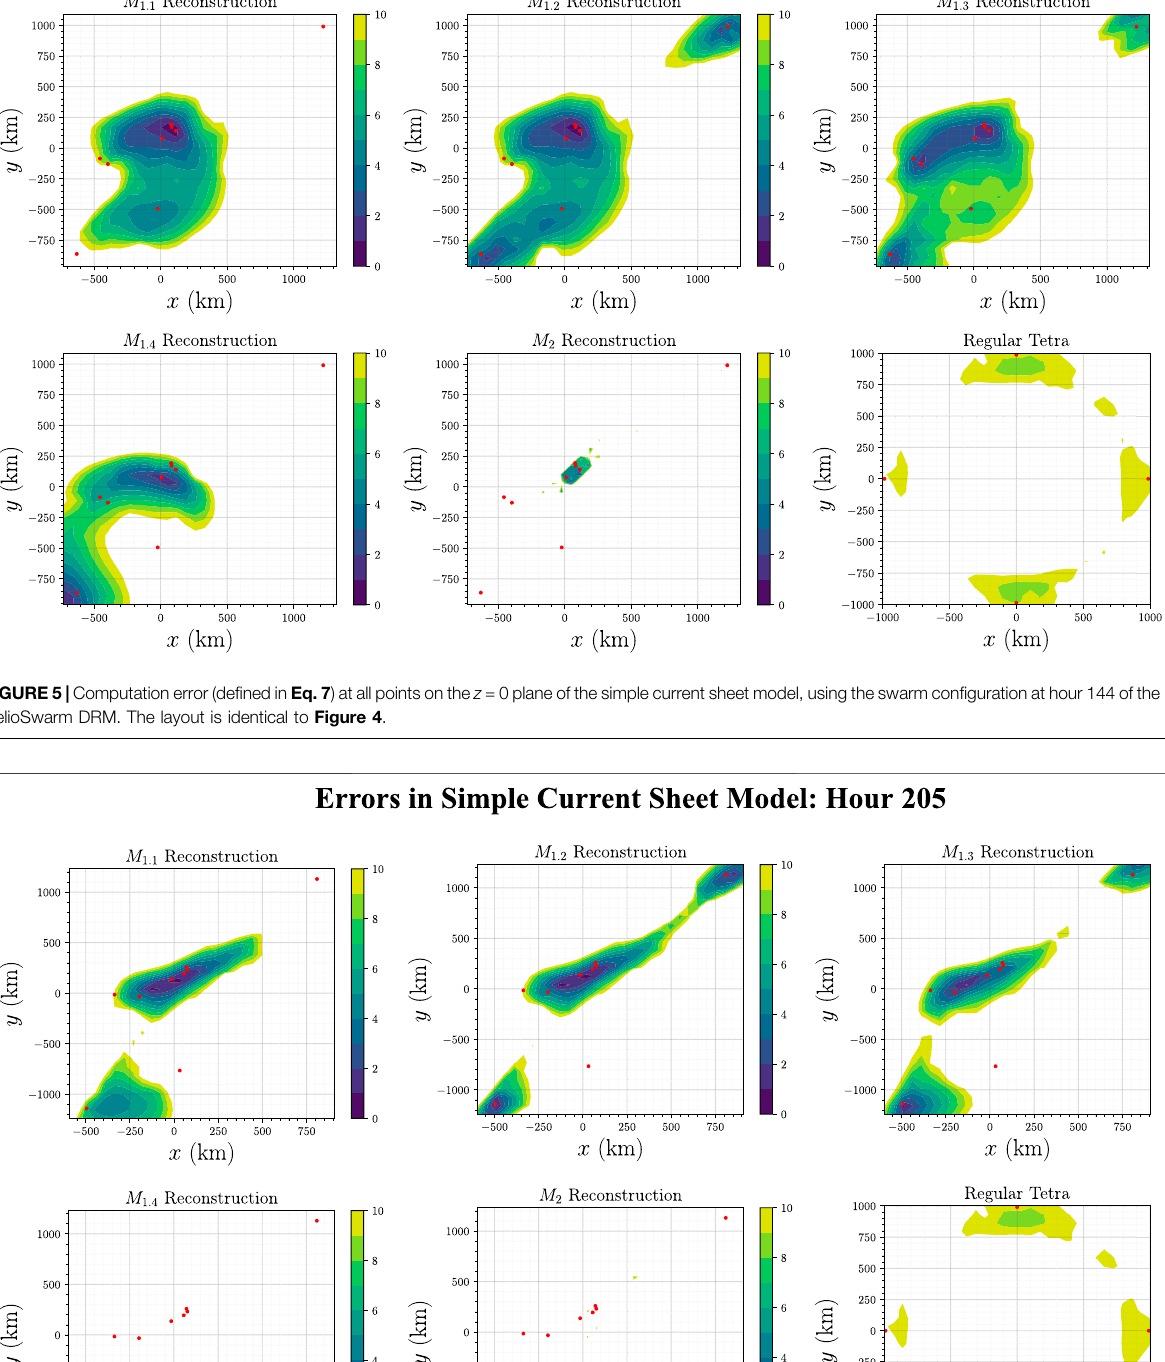
Frontiers in Astronomy and Space Sciences |